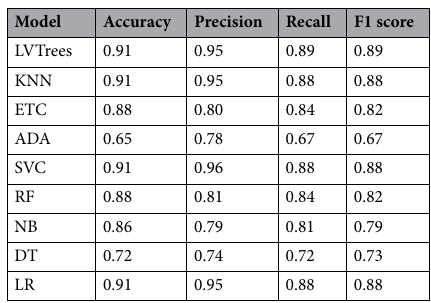
Table 11. Performance of models on original